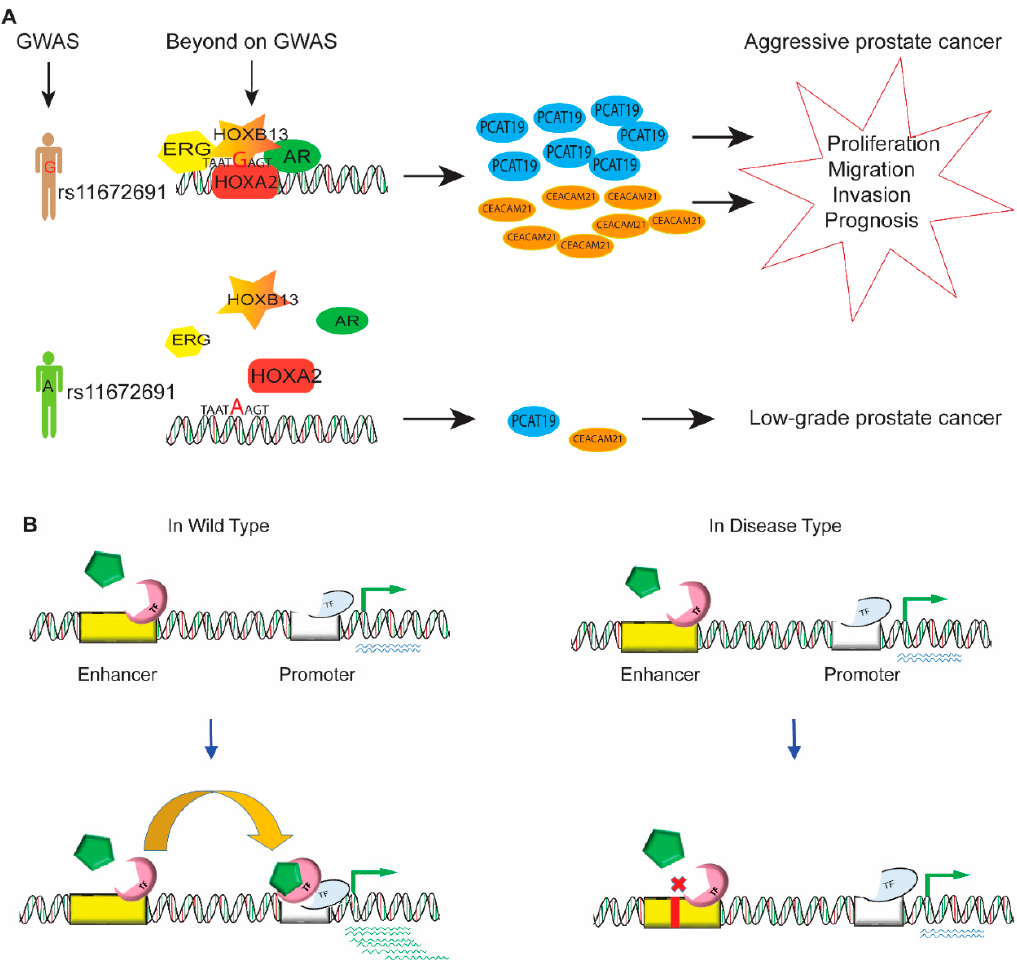
Figure 4. Enhancers in gene regulation and disease. ( A ) The aggressive G allele of rs11672691 enhances the binding of transcription factor HOXA2, thus increasing the expression level of the plausible candidate genes PCAT19 and CEACAM21, which results in prostate cancer cell growth and progression. ( B ) In wild-type cells, the driver of transcription factor binding with other factors in the enhancer region contributes to promoter interaction with the promoter of target genes to upregulate gene expression. However, in disease conditions, genetic variation and chromosomal aberrations a ff ect the binding a ffi nity of clusters of activators, mediators, and transcription factors, thereby dysregulating the expression of target